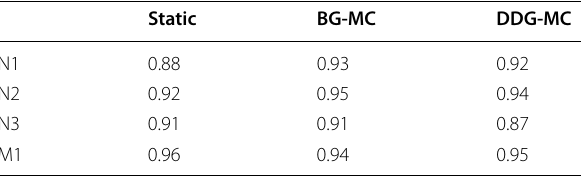
Table 2 Interobserver agreement: Cohen’s weighted kappa